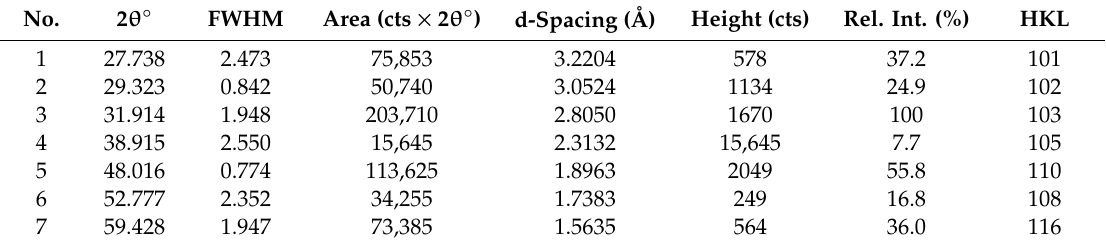
Figure 2. Powder X ‐ ray diffraction (PXRD) patterns of ( a ) CuS/C ‐ 80, ( b ) CuS/C ‐ 120, and ( c ) CuS/C ‐ 160 nanoparticles. Table 1. XRD analyses of the CuS / C-120 material (CuS-peaks). FWHM: full width at half Table 1. XRD analyses of the CuS/C ‐ 120 material (CuS ‐ peaks). FWHM: full width at half maximum.